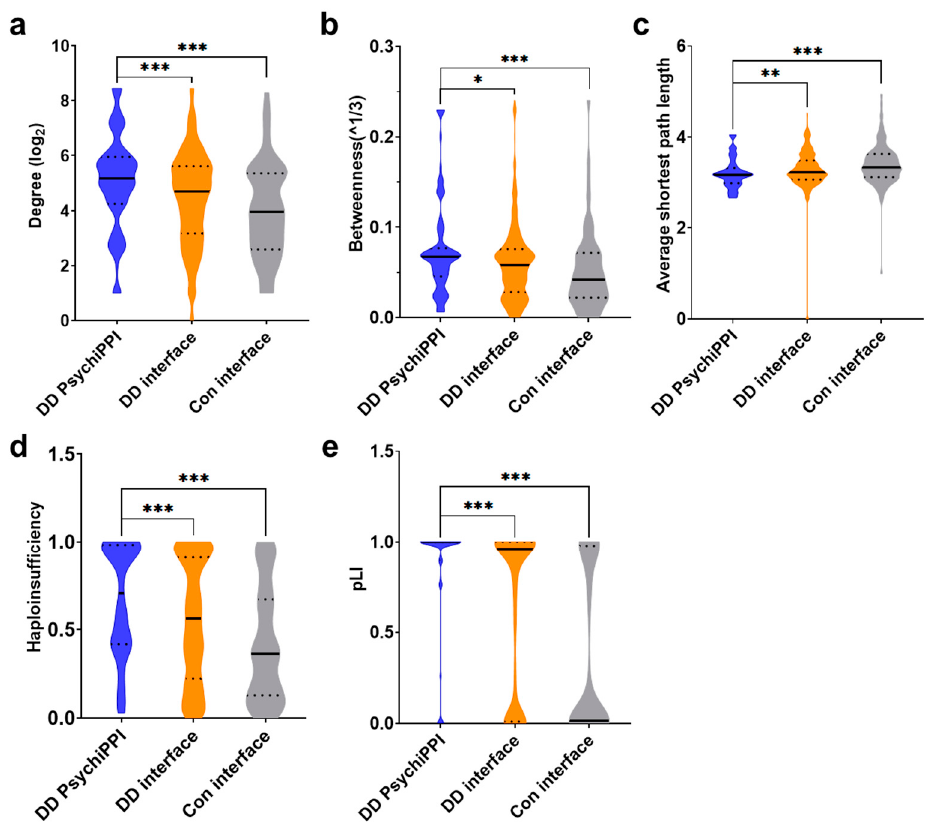
Figure 2. DD candidate genes’ human interactome and haploinsufficiency analysis. ( a , b ), Degree ( a ) and betweenness ( b ) distributions of DD candidate proteins identified by PsychiPPI, and all proteins carry PPI interface mutations in DD patients and sibling controls. Degree and betweenness values are transformed by log2 and cube root (^1/3) for presentation purposes, respectively. ( c ), Average shortest path length distributions of proteins in the respective group.( d , e ), Haploinsufficiency ( d ) and pLI ( e ) distributions of genes carry PPI interface DNM missenses. Genes with available haploinsufficiency or pLI scores were included in the analysis. (DD PsychiPPI, n = 113; DD interface, n = 472; Con, n = 122) Violin plots: black horizontal solid line, median; black dotted line, interquartile range; whiskers, upper and lower limits; the width of each plot is proportional to element abundance, p -Values were calculated using a two-tailed U -test (* p < 0.05; ** p < 0.01 ; *** p < 0.001).